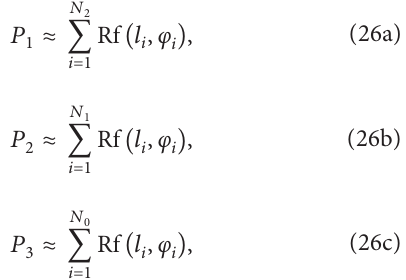
Figure 6. Assume the ratio of observed trace length and trace length of discontinuities when the midpoint of the trace falls on the zone icm is the same as that on the zone abci (in the same way for the symmetric part of zone gnd and zone fgde